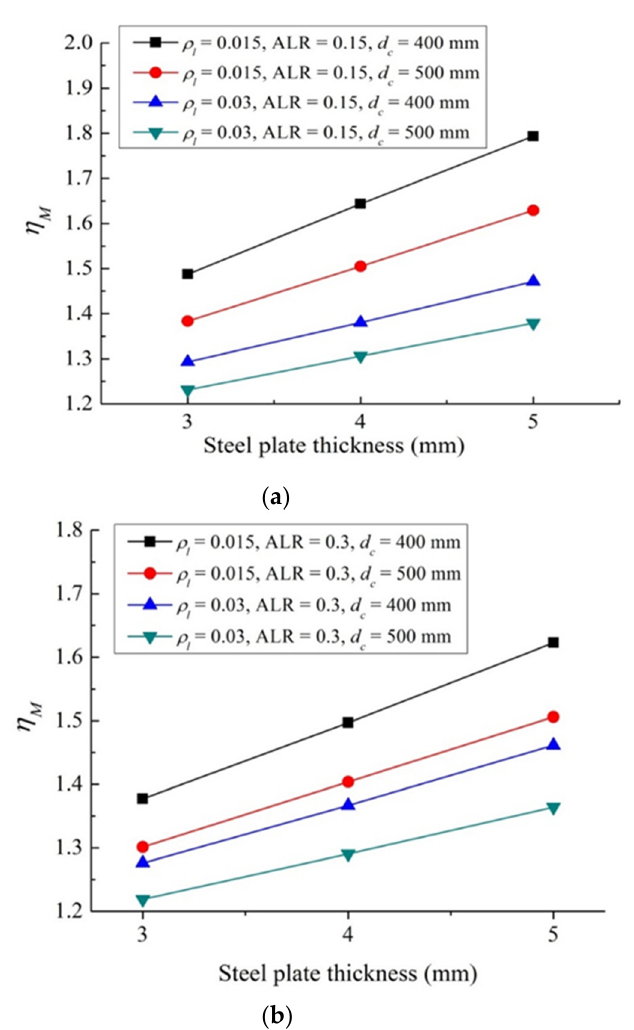
Figure 9. Enhancement of lateral load capacity: ( a ) ALR = 0.15; ( b ) ALR = 0.3.